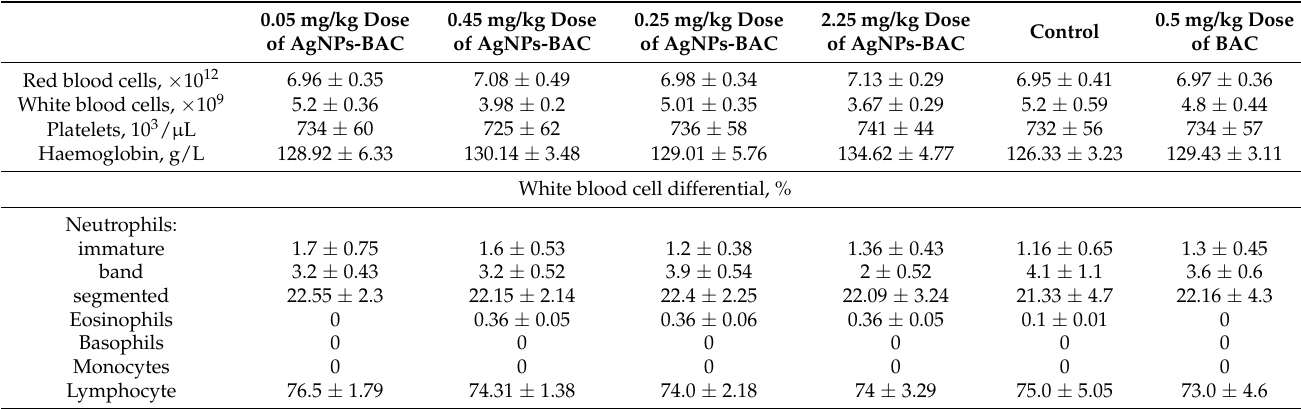
Table 4. Morphological and biochemical parameters of the mice blood after multiple intragastric AgNPs-BAC